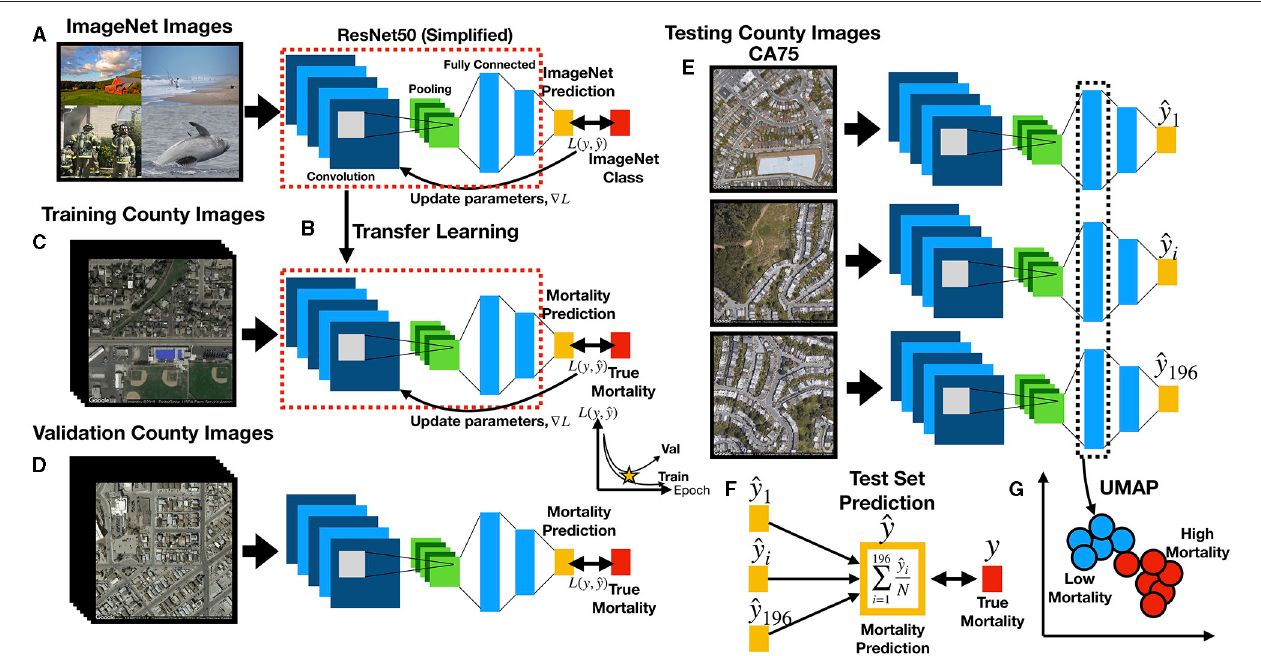
FIGURE 2 | Deep learning workflow: (A) ResNet50 model is first pre-trained on ImageNet images for the task of distinguishing 1,000 different everyday objects (e.g., farm, beach, firemen, whale); ResNet50 is comprised of multiple convolution and pooling layers (only one set shown for simplicity), which extract features and reduce the spatial dimensions of the image, respectively, and fully connected layers which represents objects at multiple levels of abstraction using vectors; prediction is compared to ground truth to estimate loss L ; the gradient is backpropagated to update the model parameters; (B) transfer learning, where parameters from pretrained model (red dashed box) serve as the initial parameters for training the country-level mortality prediction model; output layer has been replaced with a layer to predict mortality; (C) training images pass through ResNet50 to predict county-level mortality, compared to true mortality to update model parameters; (D) during training, ResNet50 model predicts mortality from images from validation counties to estimate validation loss, which is compared to training loss over training epochs to determine when training should stop to avoid overfitting; (E) trained ResNet50 model predicts county-level mortality on 196 individual images (one mortality rate prediction per image) from each test county; (F) for each test county, 196 image-level mortality rate predictions are averaged using a trimmed mean to infer the overall county-level mortality rate; the overall county-level mortality rate is correlated to true county-level mortality rate; (G) image features from images of the test counties are extracted from ResNet50 fully connected layers in the form of feature vectors, which are used to generate UMAP plots to demonstrate how mortality and other corresponding covariates (extracted from the demographic data) separate/cluster based on the image features; Spectral Clustering is used to assign image features to blue and red clusters, representing low and high mortality related images,